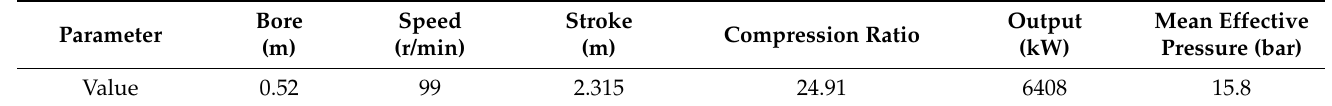
Table 1. Specifications of the test engine.